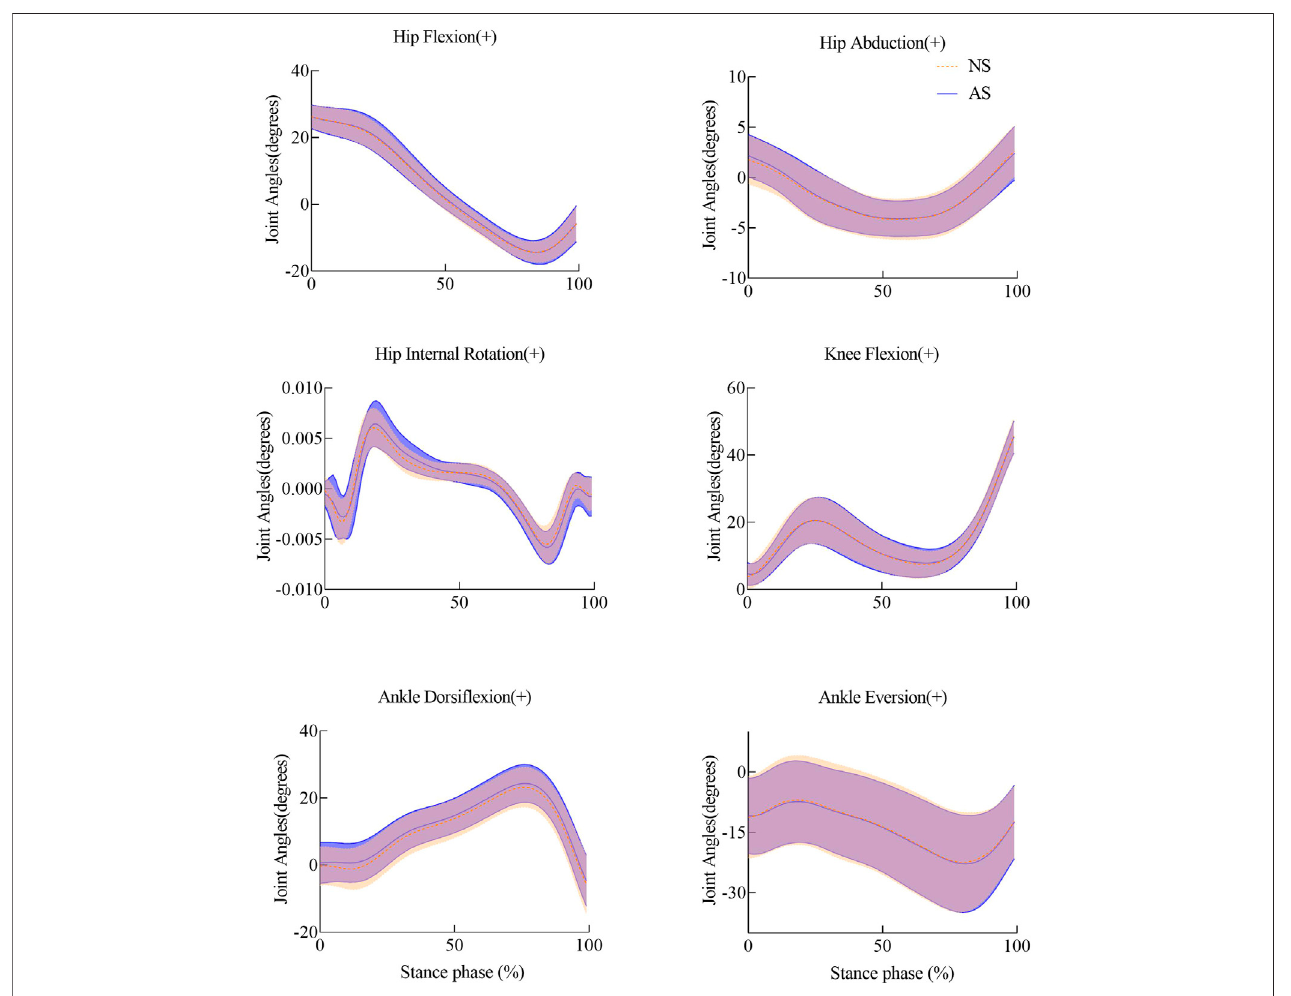
FIGURE 3 | Joint angles of lower extremities with shade ± 1 std for NS and AS during the stance phase.